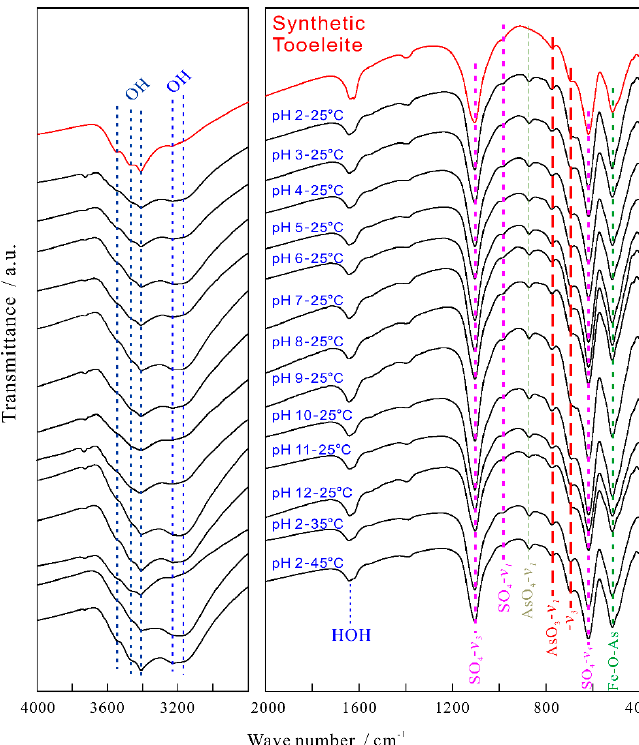
Figure 2. FT-IR spectra of the synthetic tooeleite before and after dissolution for 330 d.